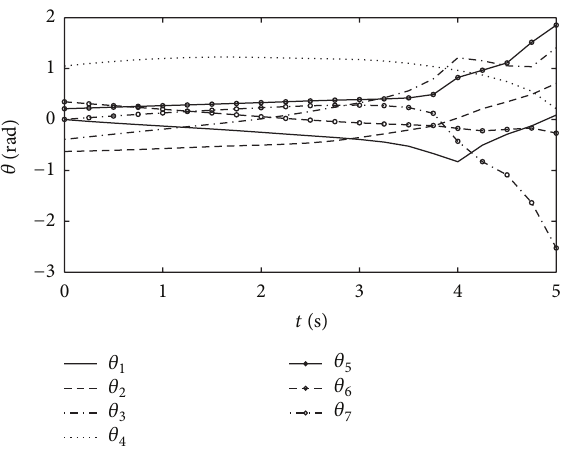
Figure 10: Angles of all